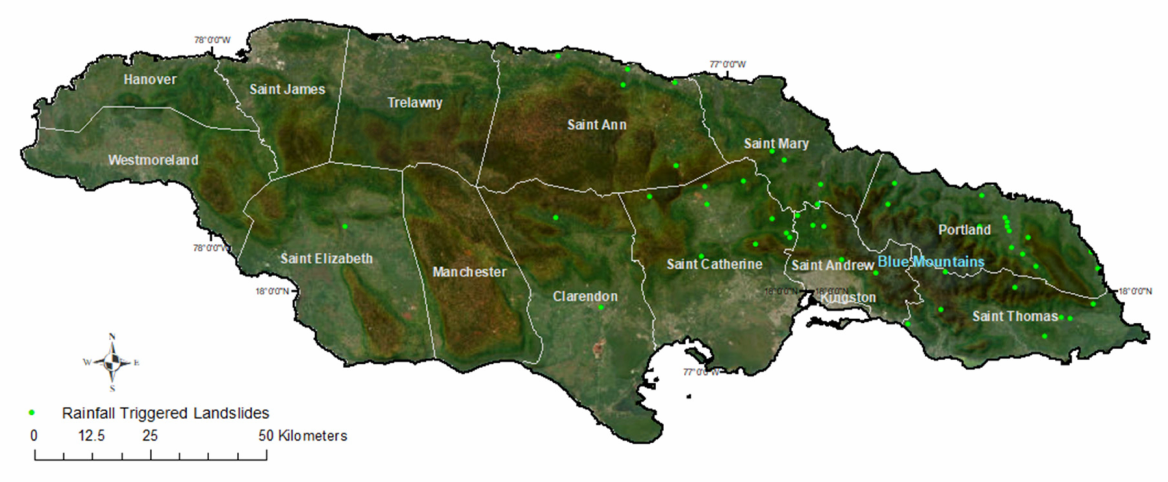
Figure 4. Rainfall Triggered Landslide between 2007 and 2017—NASA Global Landslide